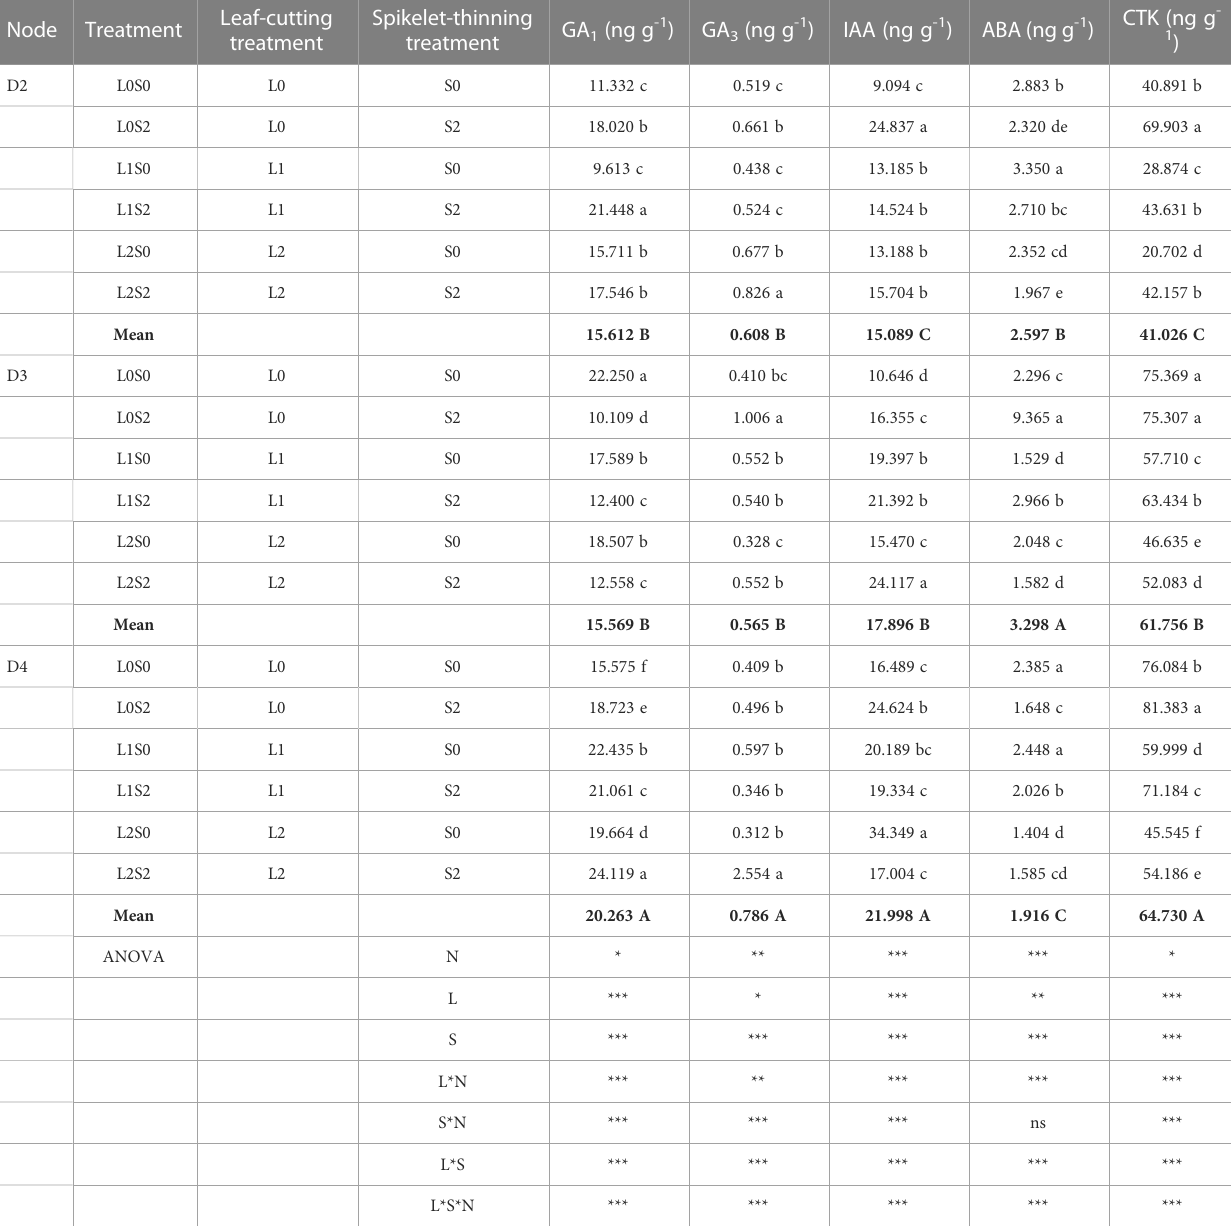
TABLE 2 Changes of endogenous hormone content in stems and buds at separate nodes at 15 days after leaf-cutting and spikelet-thinning treatment in 2018.